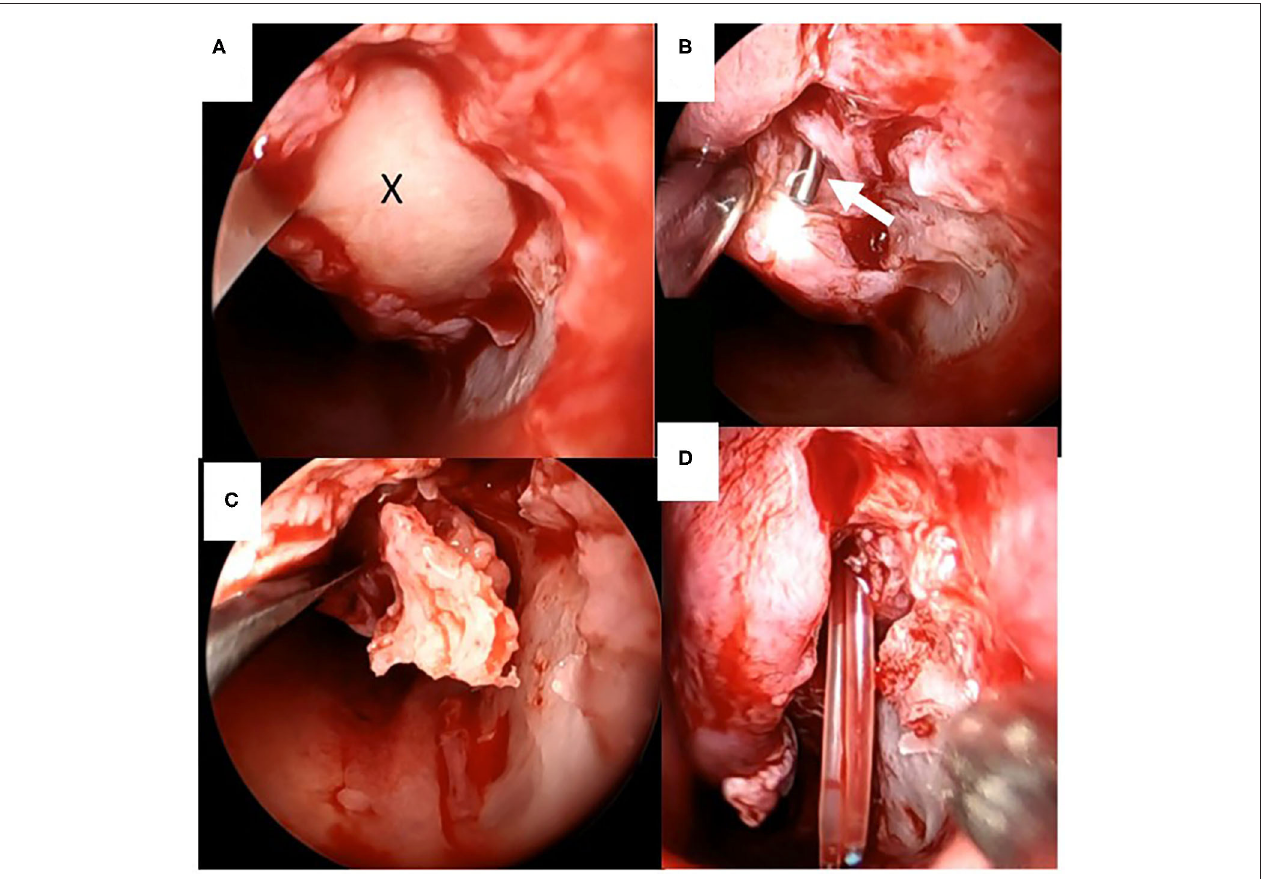
FIGURE 4 | Intraoperative endoscopic findings of marsupialization of the cystic lesion to the inferior meatus. (A) Drainage of purulent discharge (X) from the cystic lesion between the inferior turbinate and the lateral wall of the inferior meatus. (B) Tip of the lacrimal probe indicates the nasolacrimal orifice (white arrowhead). (C) The vertical bone of the inferior turbinate was separated from the surrounding tissue. (D) Silastic lacrimal intubation tubes were retrieved endonasally from the nasolacrimal